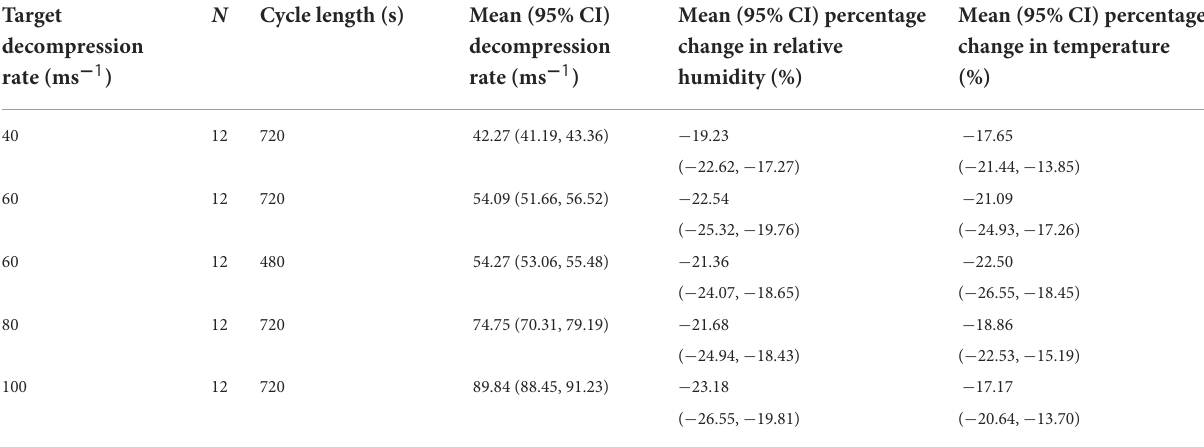
TABLE 2 Summary of hypobaric hypoxia treatments, including target decompression rate, N of pigs per treatment, cycle length, achieved decompression rates, and percentage changes of temperature and relative humidity within the chamber during a decompression cycle.